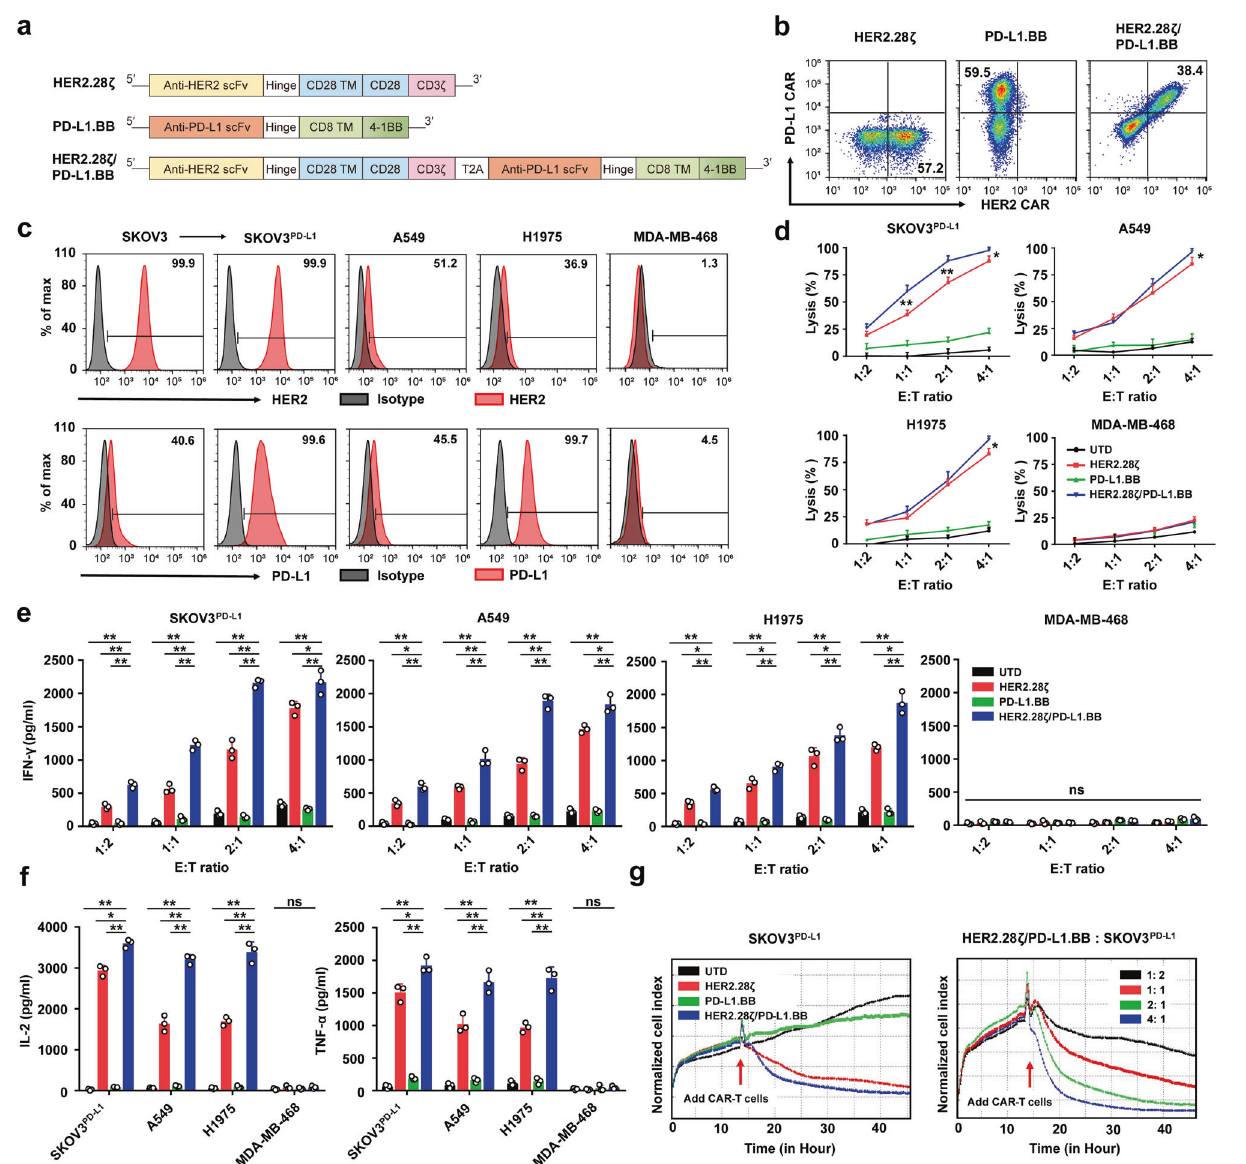
Fig. 2 PD-L1.BB CSR engagement enhances the cytotoxicity and CAR activation-induced cytokine release of HER2.28 ζ CAR-T cells. a Schematic illustration of lentiviral vectors encoding HER2.28 ζ , PD-L1.BB and HER2.28 ζ /PD-L1.BB. b Representative fl ow cytometry plots of CAR expressions on healthy donor derived CD3 + T cells. c Representative fl ow cytometry histograms of HER2 and PD-L1 expressions on various human tumor cell lines. d The cytotoxicities of CAR-T cells were analyzed by CCK-8 assay, after 24 h of co-culture with HER2 + PD-L1 + (SKOV3 PD-L1 , A549 or H1975) or HER2 - PD-L1 - (MDA-MB-468) cancer cells at various E:T ratios, and IFN- γ e , IL-2, and TNF- α f released by CAR-T cells (E: T = 2: 1) in the culture supernatant were determined by ELISA. g Continuous cytotoxicity of CAR-T cells was assessed by an xCELLigene Real-Time Cell Analysis (RTCA) system. Left: Untransduced (UTD) T cells, HER2.28 ζ , PD-L1.BB and HER2.28 ζ /PD-L1.BB CAR-T cells that co-incubated with SKOV3 PD-L1 at E: Tof 2: 1. Right: HER2.28 ζ /PD-L1.BB CAR-T cells that co-incubated with SKOV3 PD-L1 at various E: T ratios. P -values were determined by